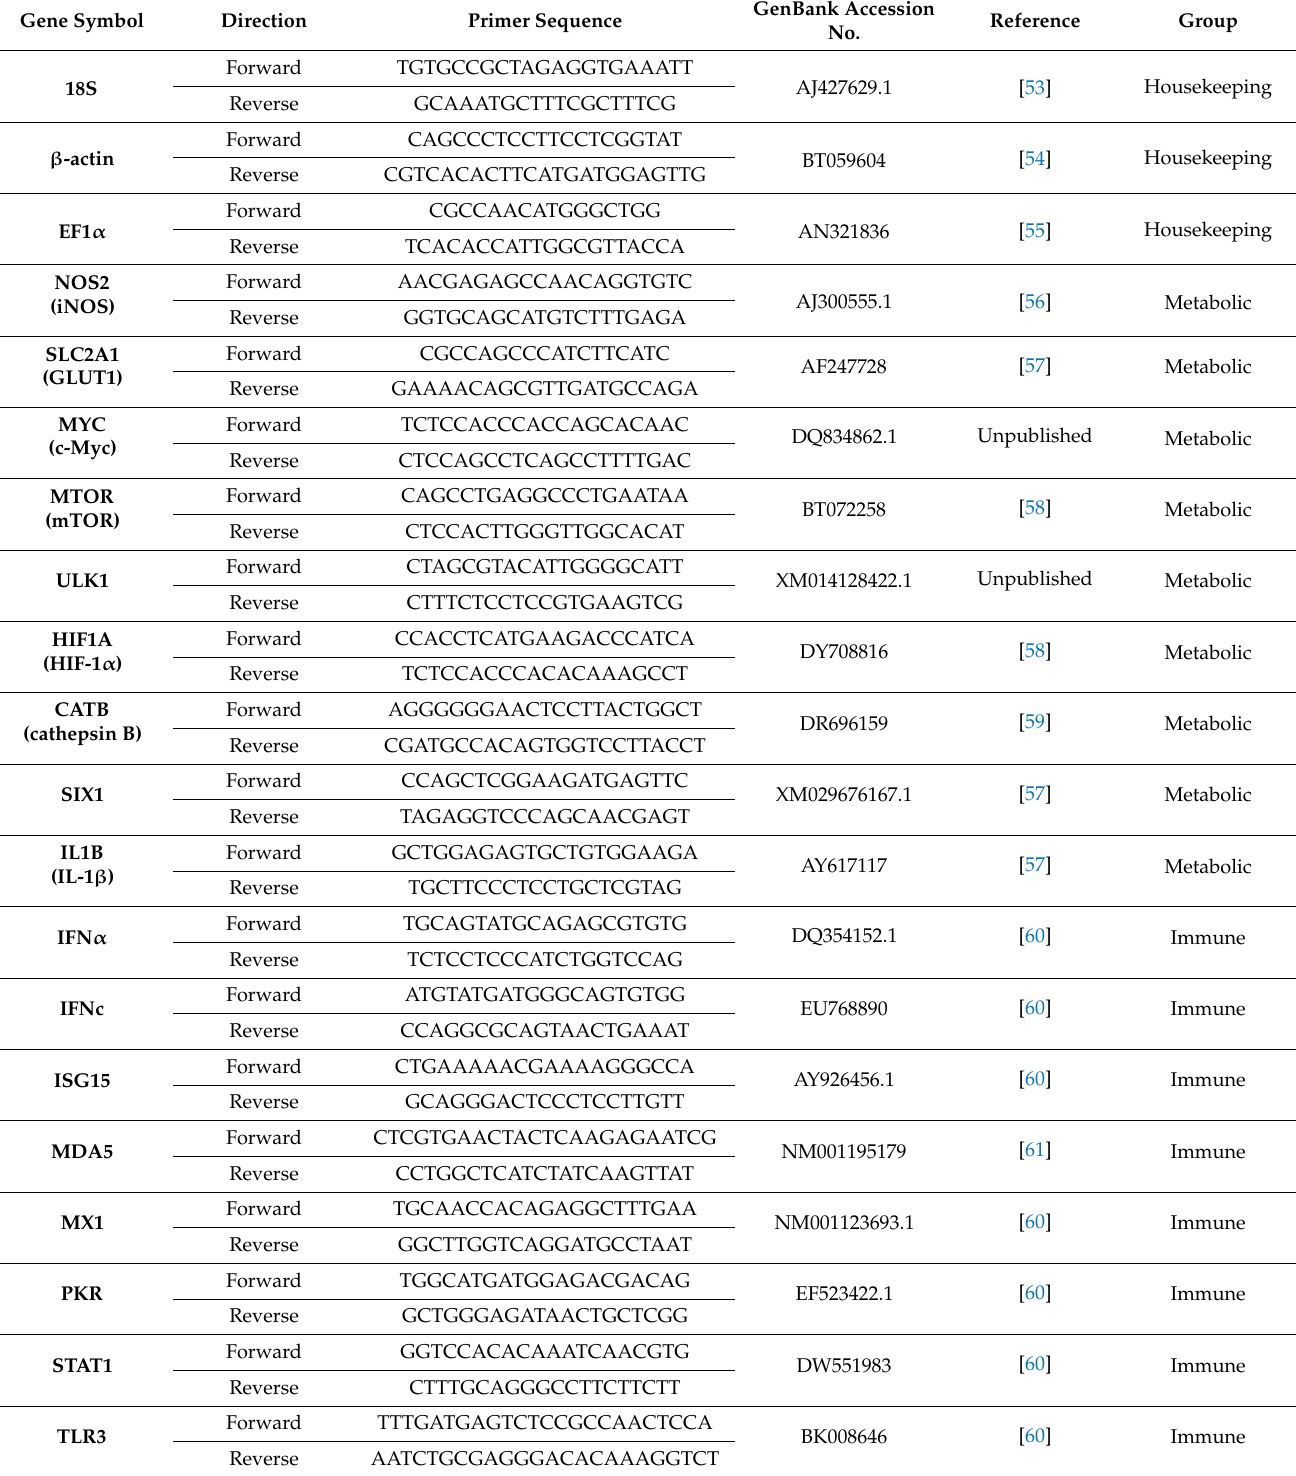
Table 3. Selected genes and primer sequences. Gene symbols follow the HUGO Gene Nomenclature Committee approved nomenclature, except for IFN α and IFNc , which are fish specific. Where available, the gene symbol associated with the GenBank accession number is displayed between